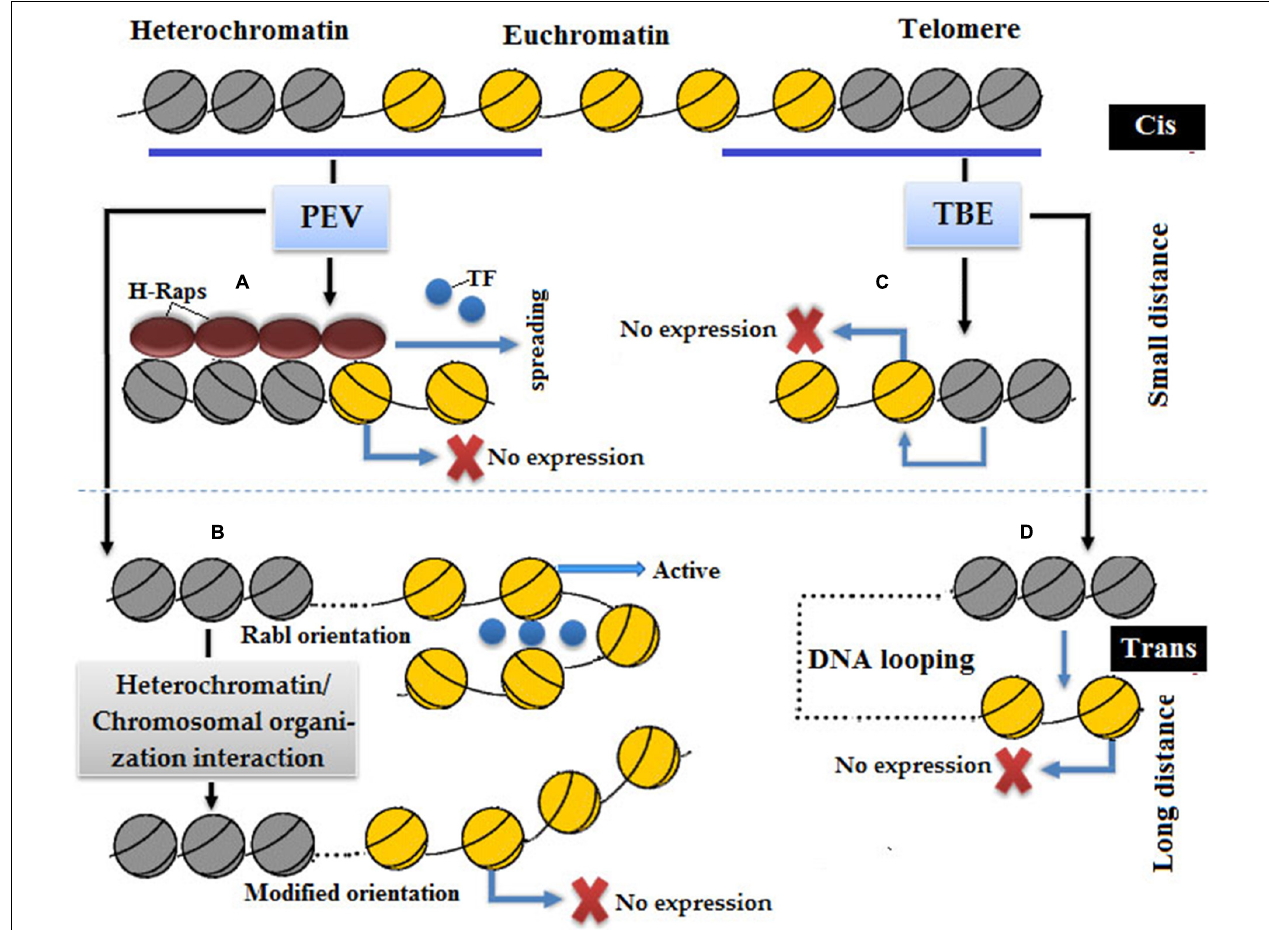
FIGURE 7 | In position effect variegation (PEV) silencing: (A) cis-spreading model in which a repressor complex, namely, invading heterochromatin proteins H-Raps stop transcription by binding with a promoter of euchromatic gene. (B) Trans-interaction in which a new chromosomal orientation leads to silencing due to the loss of transcriptional machinery. In telomeric position effect (TPE) silencing, (C) cis-spreading model in which heterochromatin quenches adjacent genes resulted in gene silencing. (D) Trans-interaction in which distantly related euchromatin and heterochromatin come closer via DNA loop formation so that heterochromatin becomes capable of quenching the expression of